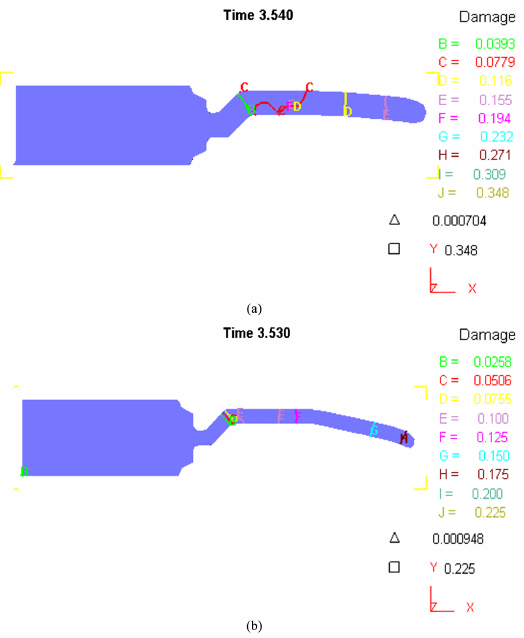
Figure 7. Crack initiation predicted by normalized Crokcroft- Latham fracture model with different extrusion ratios at 3.5 s: (a) 11.6 and (b) 28.